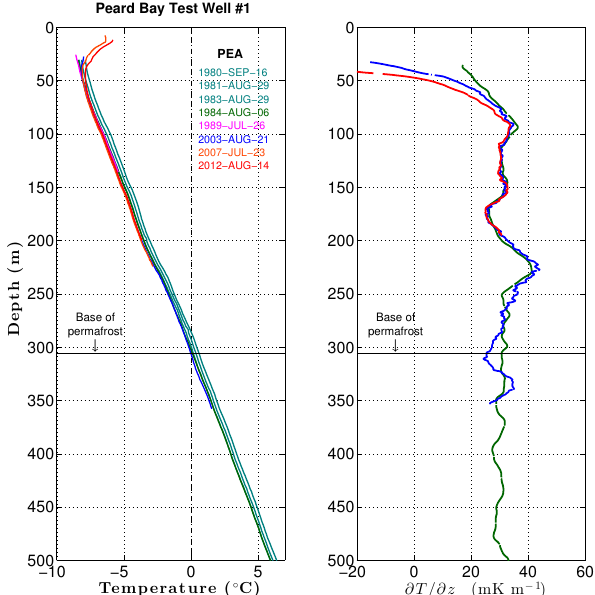
Figure 21. Temperature profiles in the North Inigok Test Well Figure 23. Temperature profiles in the Peard Bay Test Well No. 1, No. 1, color-coded by acquisition date (left). Temperature gradi- profiles in the North Inigok Test Well No. 1, color-coded by acquisition date (left). Temperature gradients calculated Figure 21. Temperature Figure 23. Temperature profiles in the Peard Bay Test Well No. 1, color-coded by acquisition date (left). Temperature gradients calculated color-coded by acquisition date (left). Temperature gradients calcu- from the 1989, 2002, and 2012 logs are shown in the right panel. ents calculated from the 1989, 2002, and 2012 logs are shown in from the 1984, 2003, and 2012 logs are shown in the right panel. lated from the 1984, 2003, and 2012 logs are shown in the right the right panel.